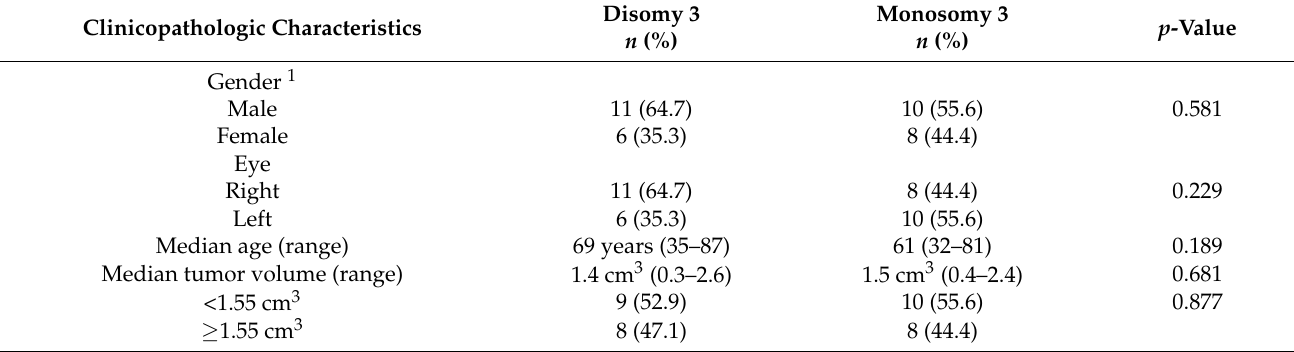
Figure 2. Presence of UM-specific chromosomal rearrangements detected by MLPA analysis. * partial loss/gain. Table 3. Association between diverse clinicopathologic characteristics and Monosomy 3